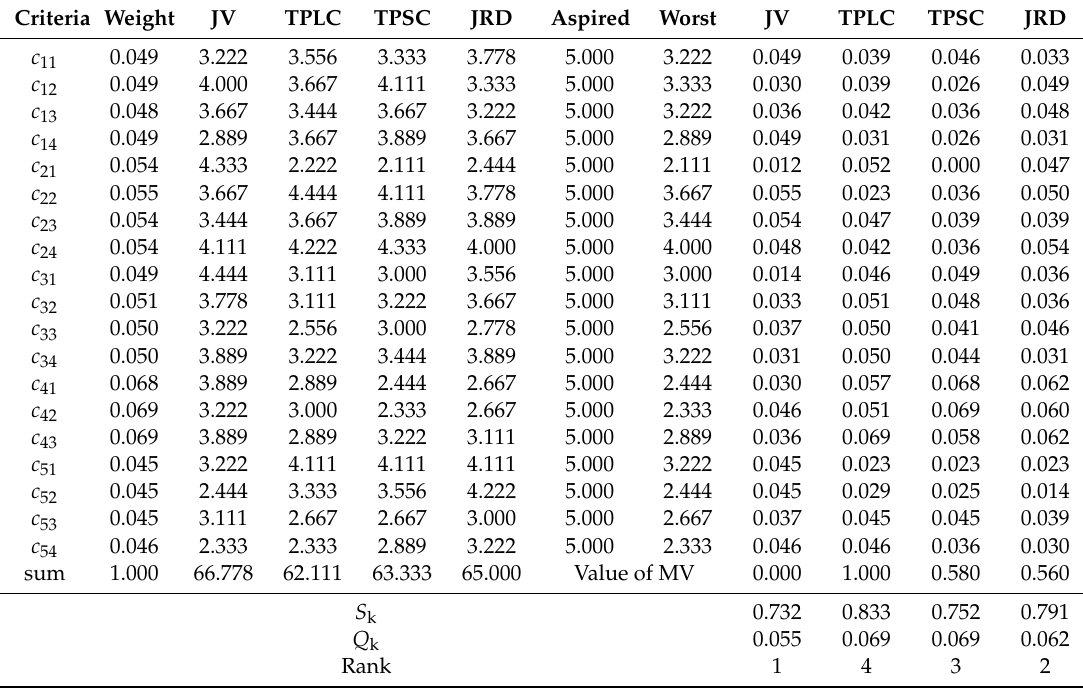
Table A3. The results of VlseKriterijumska Optimizacija I Kompromisno Resenje